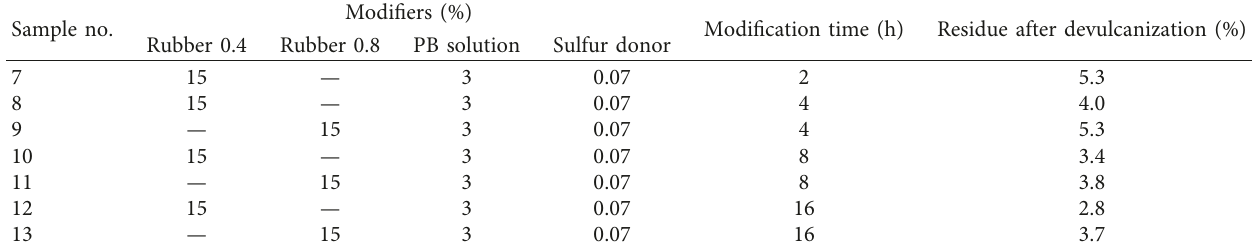
Table 2: Bitumen modification at 220 °